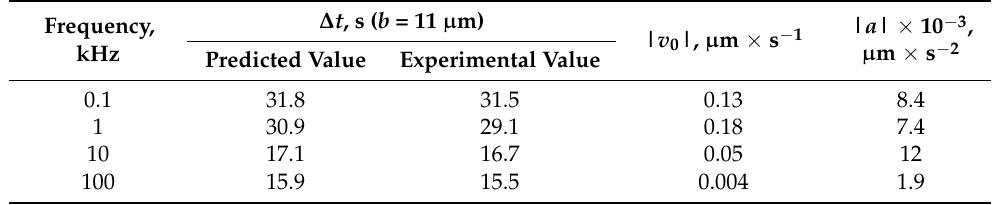
Table 2. Deduced values for the BNNSs under nanosecond pulses.